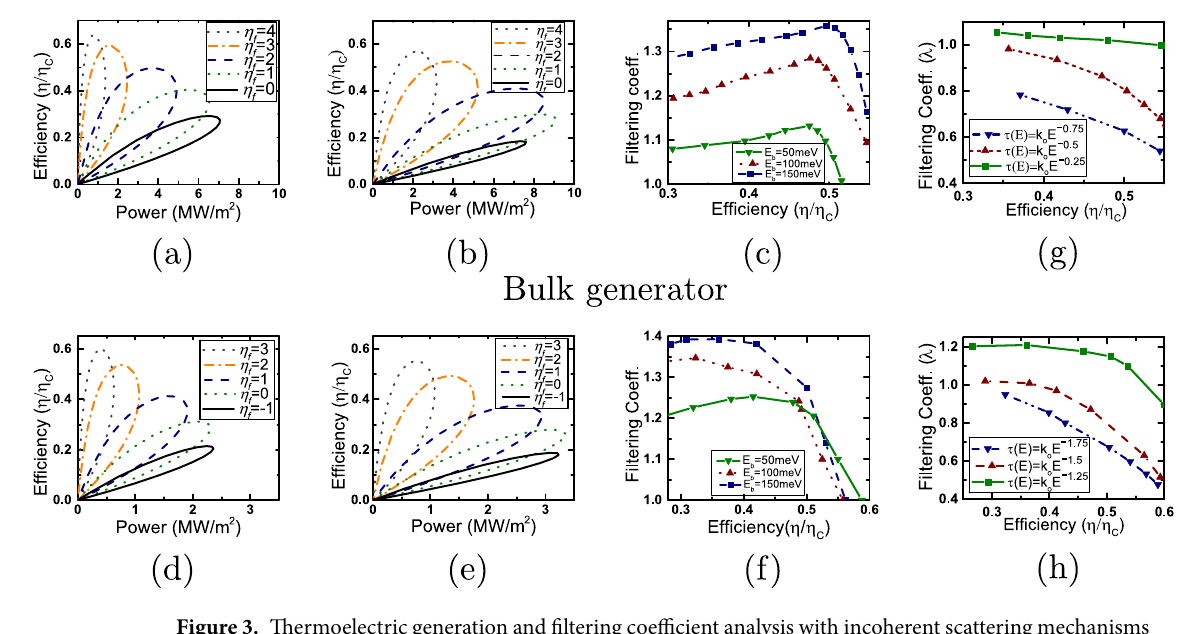
Figure 3. Thermoelectric generation and filtering coefficient analysis with incoherent scattering mechanisms ( a – c ) Analysis for a square nanowire of length 20 nm and width 2.7 nm with the inclusion of acoustic phonon E c scattering: ( a ) Power-efficiency trade-off analysis in case of Approach A for various values of η = µ − . ( b ) f k T B E E E c b Power-efficiency trade-off analysis in case of Approach B for various values of η = − − ( E b = 150 meV and f k T B = 2.7 nm ). ( c ) Filtering coefficient plotted for various heights of the energy filtering barrier. ( d – f ) Analysis for σ w a bulk generator of length 20 nm with the inclusion of acoustic phonon scattering: ( d ) Power-efficiency trade-off E c analysis in case of Approach A for various values of η = µ − . ( e ) Power-efficiency trade-off analysis in case of f k T B E E E c b Approach B for various values of η = − − ( E b = 150 meV and σ w = 2.7 nm ). ( f ) Filtering coefficient plotted f k T B for various heights of the energy filtering barrier. ( g – h ) Filtering coefficients plotted for higher order scattering mechanisms with Gaussian energy barriers ( σ w = 2.7 nm , E b = 150 meV ) for ( g ) nanowire generator with dimensions used in ( a – c and h ) bulk generator with dimensions used in ( d – f